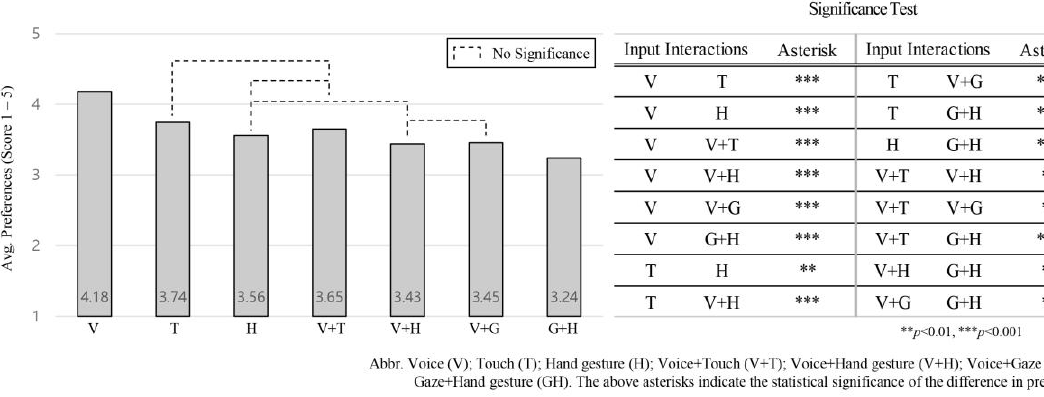
Figure 5. Average preference for the seven input interactions according to “the five parameters” across all intervention scenarios and NDRTs.